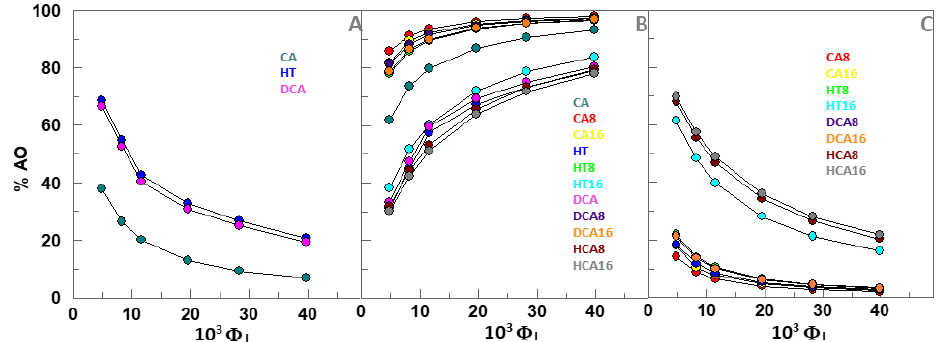
Figure 2. Percentage of the different AOs in the aqueous ( A ), in the interfacial ( B ) and oil ( C ) regions as a function of the Tween 20 emulsifier fraction ( Φ I ), for a 4:6 (O/W) emulsion (olive oil/citrate buffer, pH = 3.65/Tween 20).